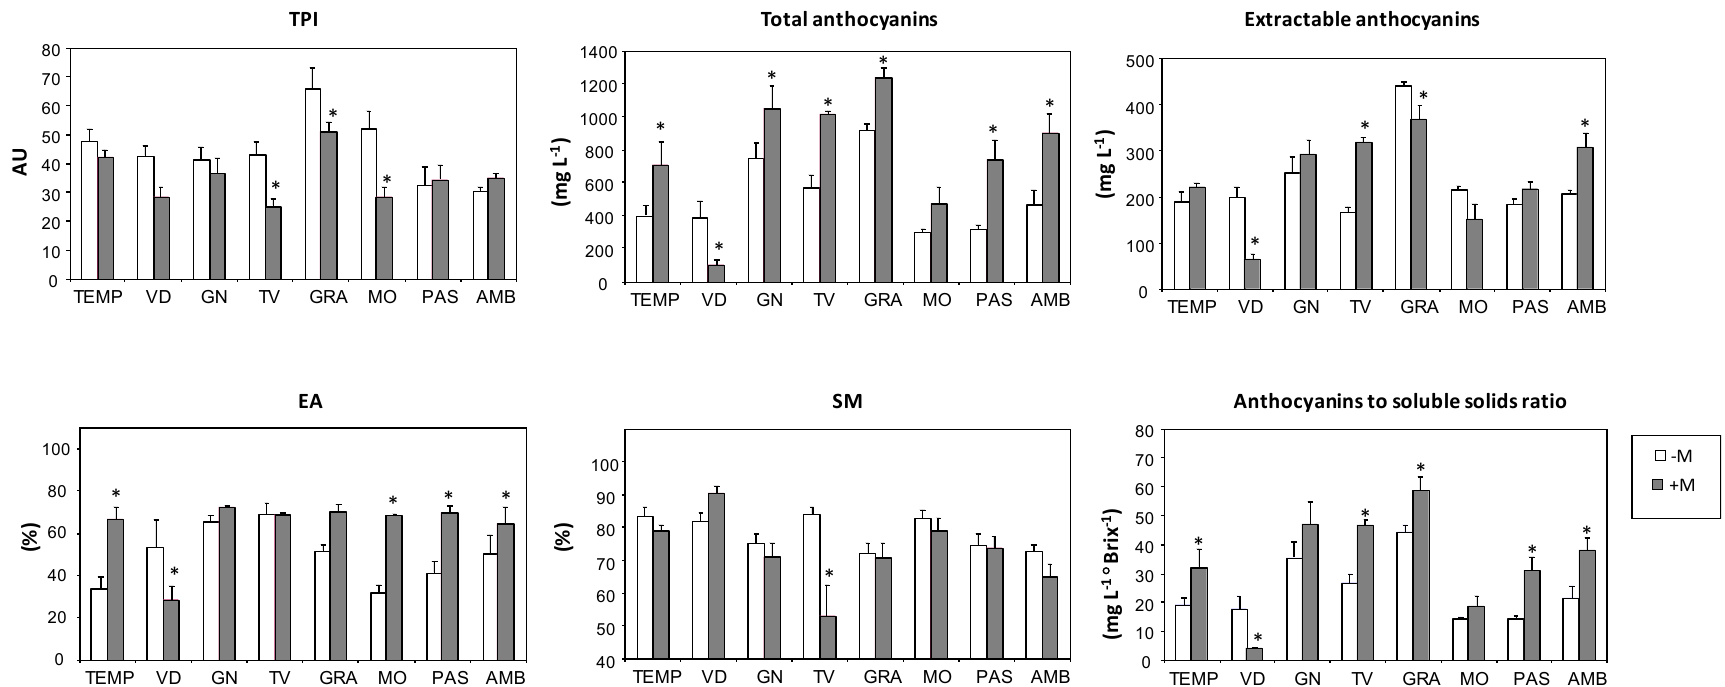
Figure 7. Phenolic composition of berries from fruit-bearing cuttings of ancient grapevine varieties inoculated with arbuscular mycorrhizal fungi (+M) or non-inoculated (-M). Values are means ± S.E. (n = 3-4). Within each variety, asterisks (*) indicate significant differences ( p ≤ 0.05) between +M and –M plants according to Duncan’s test. The variety labels can be found in Table 1. TPI: total polyphenol index; EA: cellular extractability of anthocyanins; SM: seed maturity; AU: absorbance units.